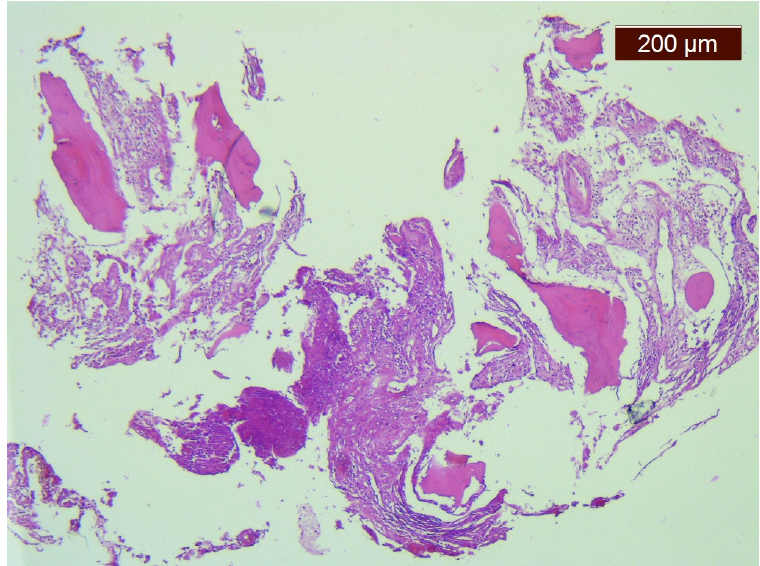
Figure 2. Microscopical aspect of bone marrow biopsy showing fibrosis, foci of osteolysis, and moderate inflammatory infiltrate with lymphocytes and plasma cells (HE, ×50).